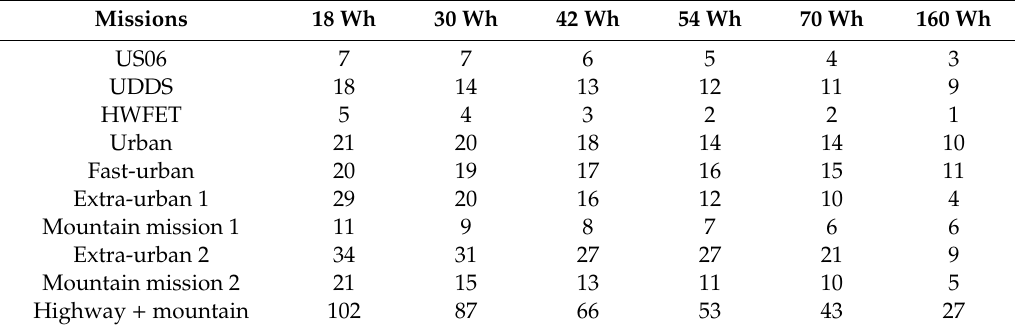
Table 4. Diesel engine number of starts while speed is above USL as a function of NZ sizing (i.e., NZ Wh). Values approximated to the nearest